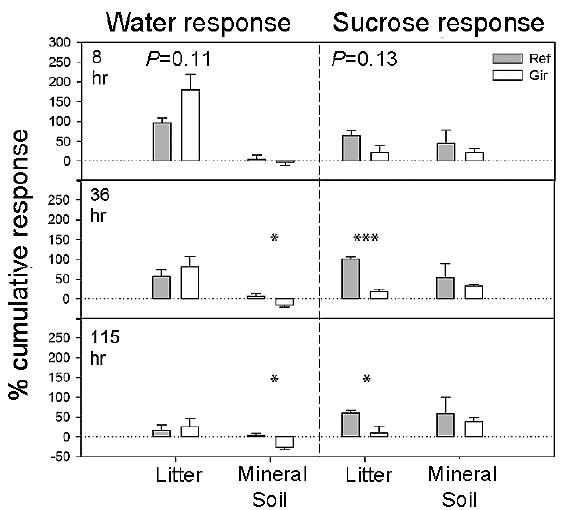
Fig. 7. Response of respiration to water and sucrose additions at the reference site (grey bars) and the girdled site (white bars). Standard error bars are shown ( n = 3). Limitations to water and sucrose in the litter were calculated from the accumulation of respired carbon over three time periods following treatment application: from the first three measurement cycles (8h), from the first 36h, and from the entire duration of the experiment (115h), using cumulative C fluxes and Eq. (1). Asterisks denote significant differences between the two sites (t-test, ∗ P ≤ 0 . 05; ∗∗ P ≤ 0 . 01; ∗∗∗ P ≤ 0 . 001). P values are shown for tests not meeting the α criteria of 0.05 but were less than